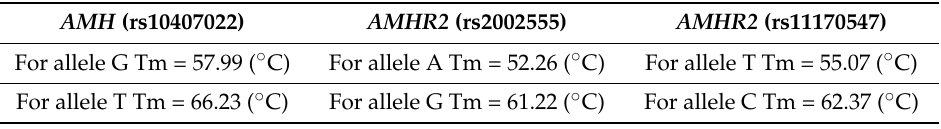
Table 1. Analysis of melting curves for different alleles of AMH and AMHR2